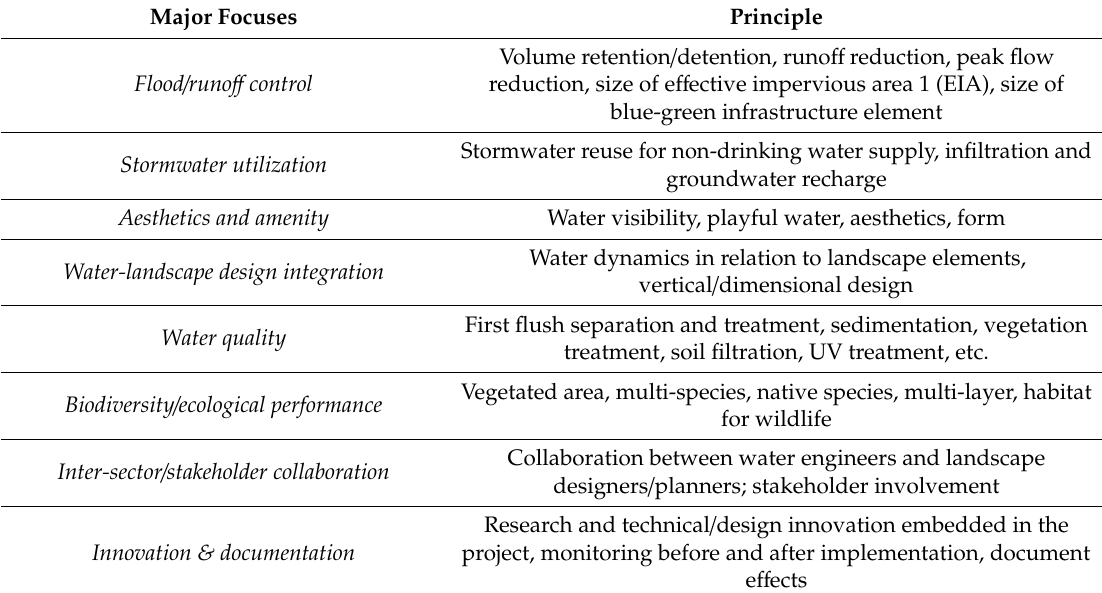
Table 1. Major focuses of blue-green infrastructure projects for sustainable urban stormwater management. Based on e.g.,